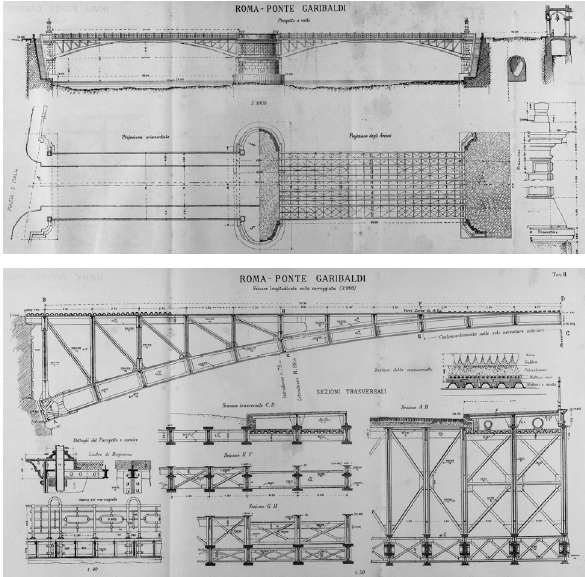
Figure 10. Detailed project of Garibadi Bridge (Bonato, 1889)